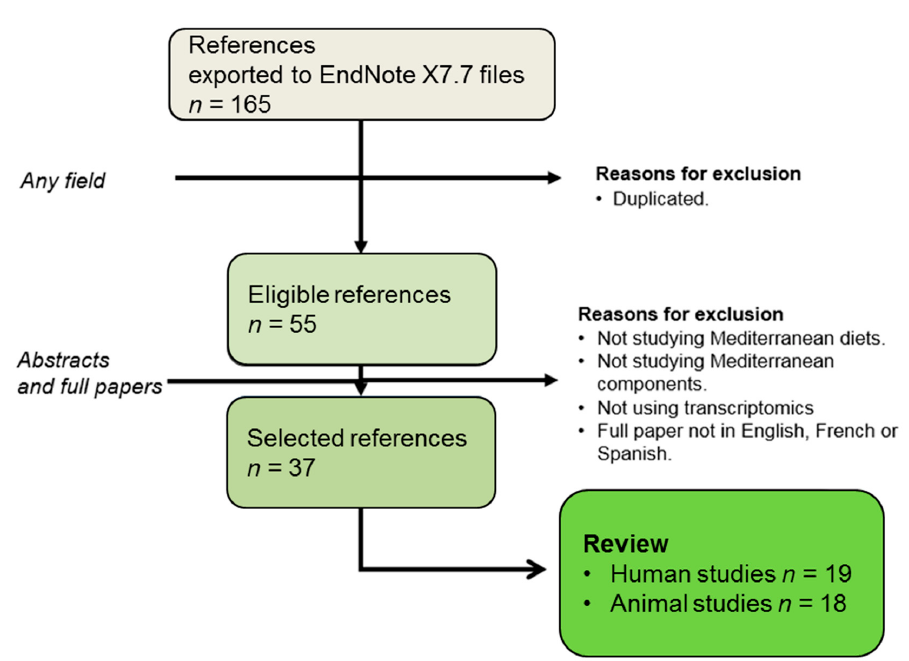
Figure 2. Flow chart displaying the stages used to select the references considered. EndNote X7.7 (Bld 9325 Thomson Reuters: New York, NY, USA, 2016).